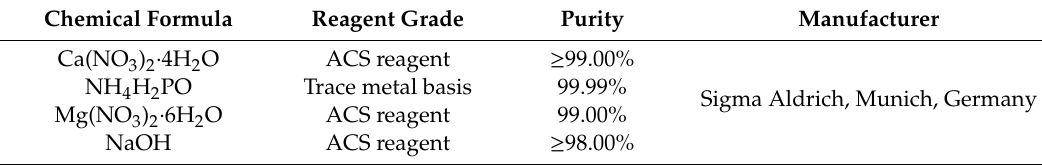
Table 2. Grade and purity of the chemical reagents employed in electrolytes preparation.